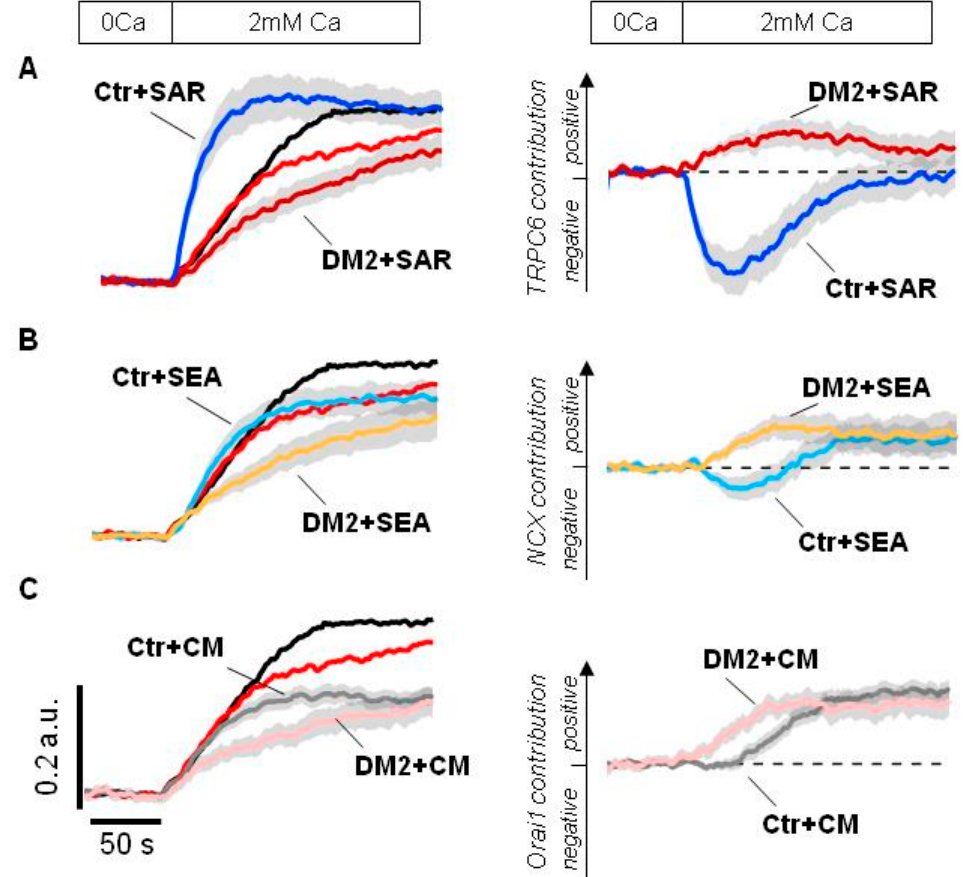
Figure 7. An inhibitory analysis of Ca 2+ influx into the rat glomerular podocytes. ( A – C ) Shown are averaged fura-2 fluorescence ratio in response to Ca 2+ store depletion by application of 2 µM Tg for 4 min in glomerular podocytes from control (Ctr, black) and diabetic (DM2, red) rats. Left—original traces aligned to the fluorescence ratio level before Ca 2+ addition; shown are traces recorded in the presence of DMSO or indicated inhibitor. Right—difference between Ca 2+ response in the presence of DMSO minus Ca 2+ response in the presence of indicated inhibitor, the ordinate axis reflects the positive and negative contribution of the indicated pathway, estimated by the effect of corresponding inhibitor. Inhibitors were applied in 0 mM Ca 2+ for 4 min together with 2 µM Tg and kept till the end of experiment. 1 µM SAR7334 (panel A), 5 µM SEA0400 (panel B) and 1 µM CM4620 (panel C) were used. The scale bars shown on the left are the same for all panels. Traces shown as Mean ± S.E.M. values.